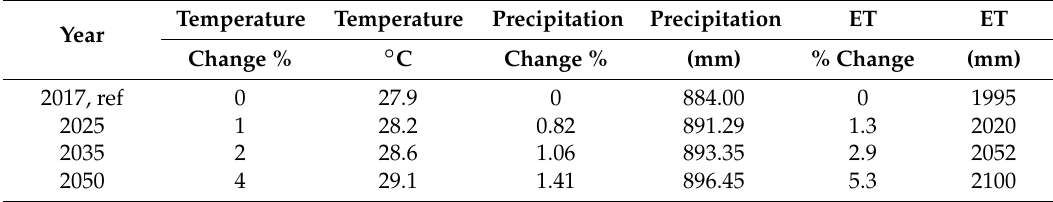
Table 3. Percentage changes for temperature, precipitation and ET and its projection referenced to